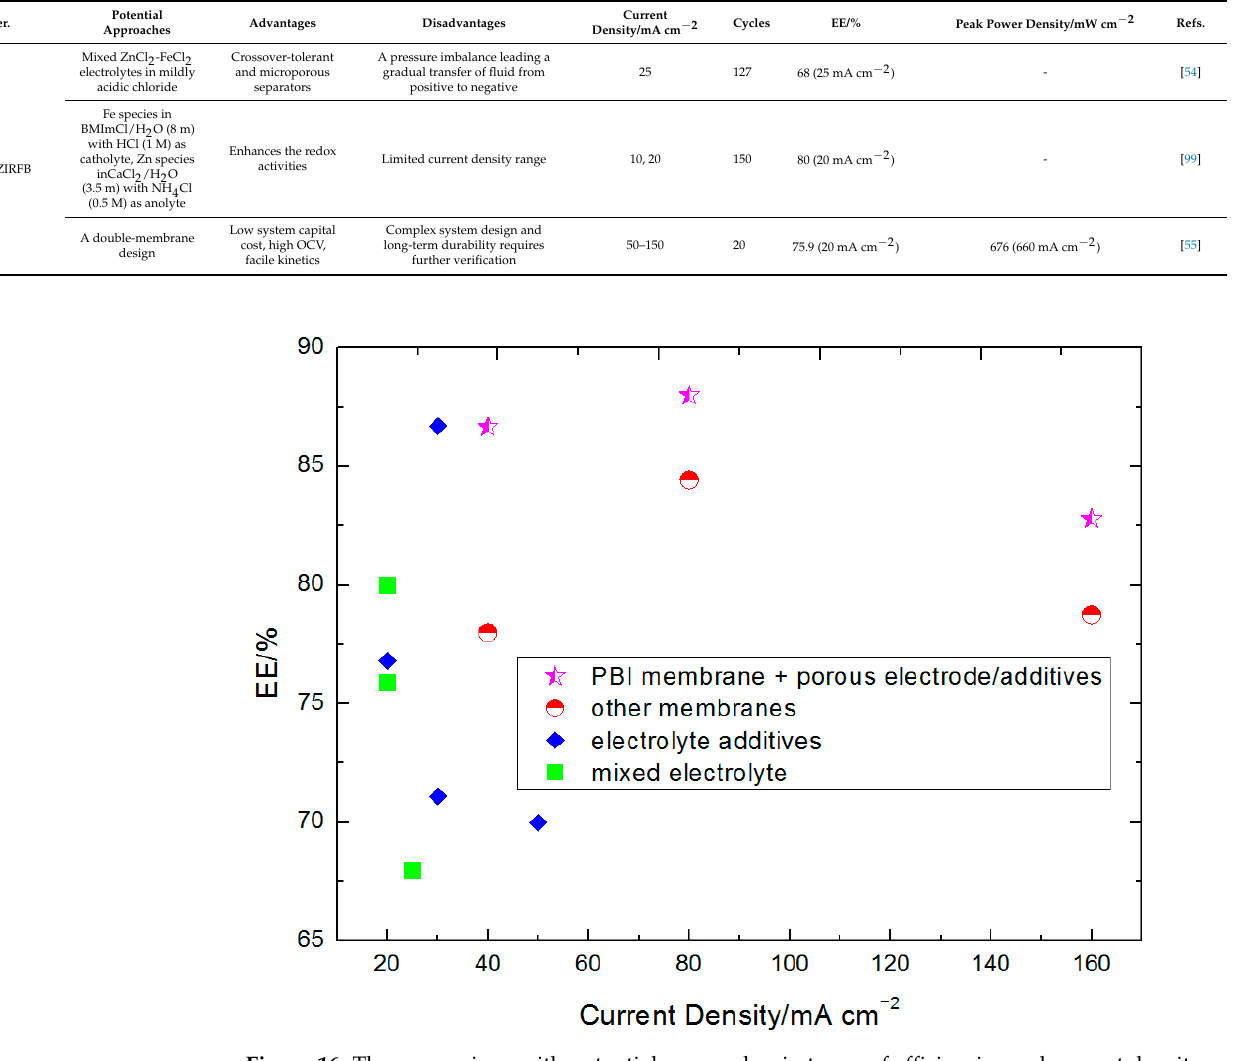
Figure 16. The comparison with potential approaches in terms of efficiencies and current density. Table 5. The comparison with potential approaches.